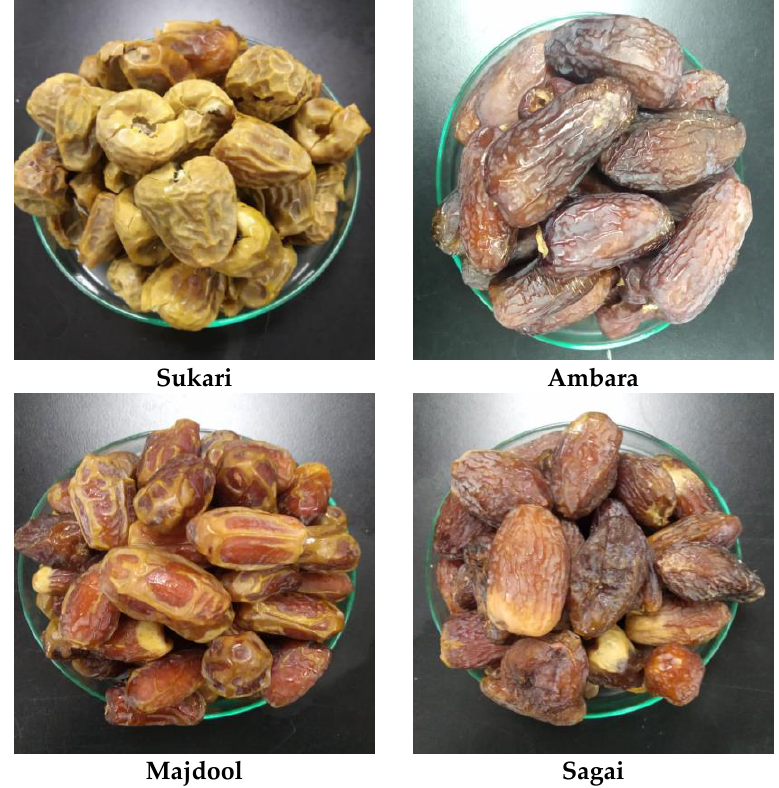
Figure 1. Date Fruits from Four Date Cultivars grown in Saudi Arabia.